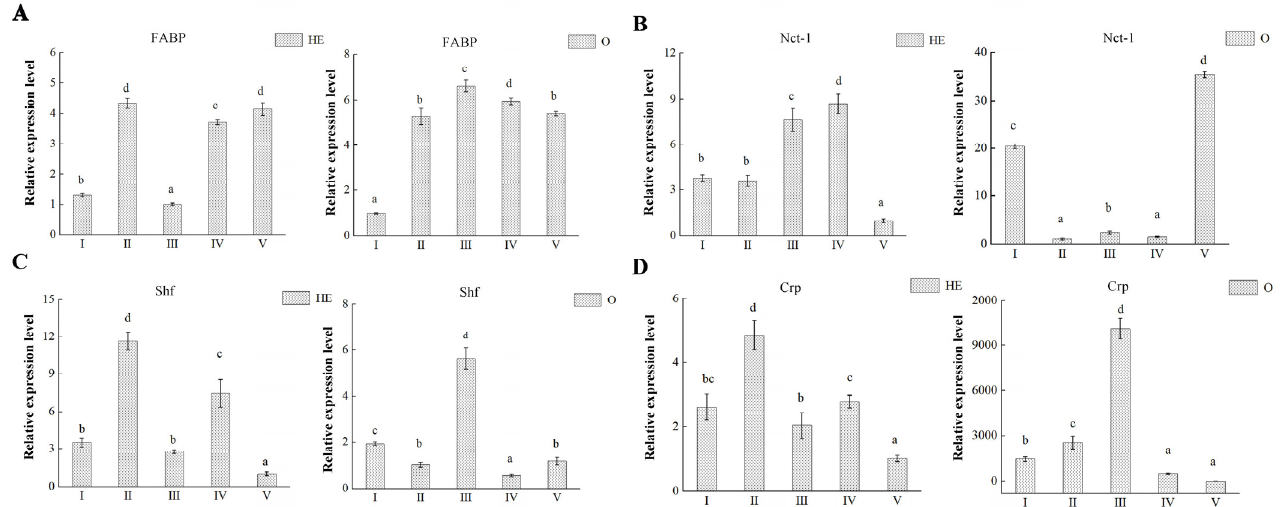
Figure 8. mRNA expression profiles of 4 proteins in both hepatopancreas and ovary during five ovary stages. ( A ) FABP , ( B ) Nct-1 , ( C ) Shf , ( D ) Crp . Data are shown as mean ± SD ( n = 3). Statistical analyses were performed with one-way ANOVA analysis. a, b, c, and d denote significant differences ( p < 0.05) and same letter means no significant difference ( p > 0.05).